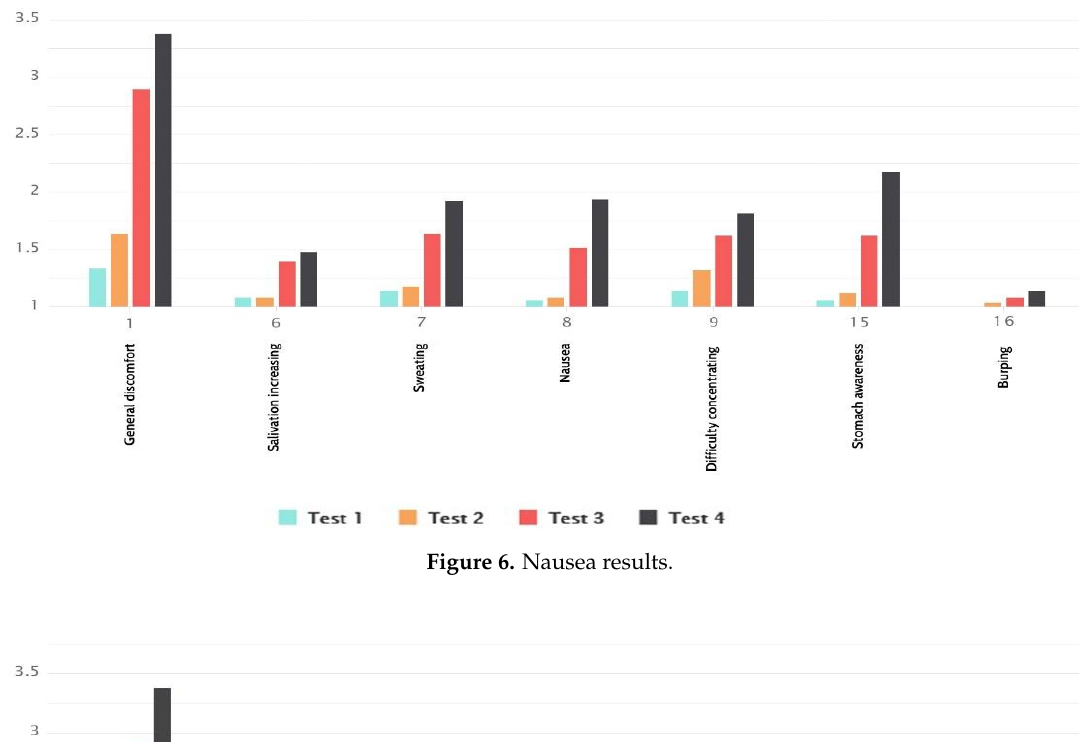
Figure 6. Nausea results.